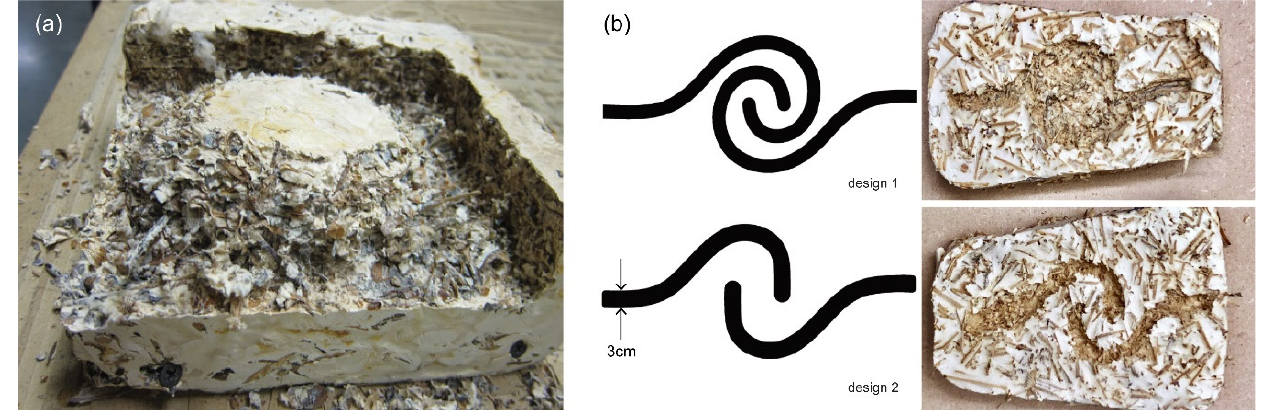
Figure 4. Two examples of MBC grown in a mould, rendered inert, and CNC milled thereafter Reproduced and reprinted with permission from: ( a ) Peek; 2021 [45]; and ( b ) Lazaro et al., Proceedings of the UbiComp/ISWC; 2019 [46].